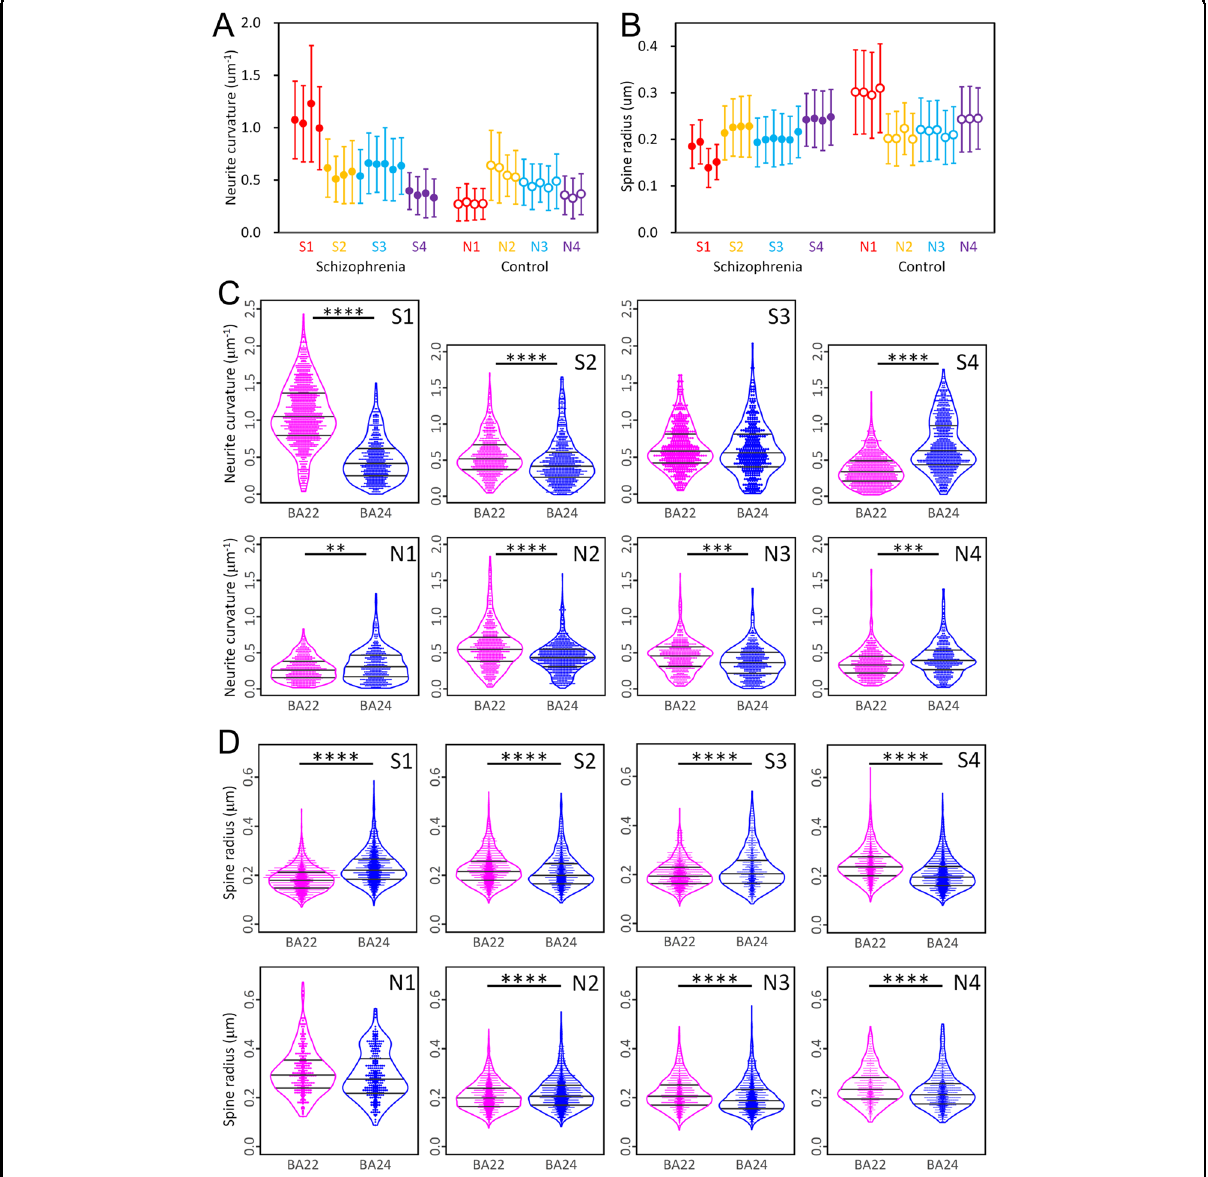
Fig. 2 Differences in neuron structure between brain areas and between cases. A , B Neurite curvature ( A ) and spine thickness radius ( B ) of temporal (BA22) cortex calculated from each dataset vary depending on the cases ( p = 2.9 × 10 − 8 and F = 91.7, for neurite curvature, p = 4.5 × 10 − 8 and F = 74.9, for spine radius, Welch ’ s ANOVA with case as the main factor). Schizophrenia cases S1 – S4 and age/gender-matched control cases N1 – N4 are color-coded. Neurite curvature was calculated by averaging the curvature along the neurite. Spine radius was calculated by averaging the thickness radius along the dendritic spine. Circles indicate mean values of each dataset, and error bars indicate standard deviation. C , D Frequency distribution of neurite curvature ( C ) and spine radius ( D ) of temporal (BA22) and prefrontal (BA24) cortexes of each case. Schizophrenia cases S1 – S4 and controls N1 – N4 are indicated with labels. The equality of distributions between BA22 and BA24 was examined using Kolmogorov – Smirnov test, and their p values were corrected with the Holm – Bonferroni method. **** p < 10 − 8 ; *** p < 10 − 4 ; ** p < 10 − 2 . Quartiles are indicated with bars. Dot size is adjusted for visibility. E Mean spine length is signi fi cantly shorter in BA22 than in BA24 (* p = 0.023, F = 6.7, two-way ANOVA with group (schizophrenia/control) and brain area (BA22/BA24) as main factors). Schizophrenia cases S1 – S4 and controls N1 – N4 are color-coded. F Mean neurite curvature is signi fi cantly higher in the schizophrenia cases than in the controls (* p = 0.031, F = 5.9, two-way ANOVA with group (schizophrenia/control) and brain area (BA22/BA24) as main factors). G Neurites of BA22 of the schizophrenia S1 case are tortuous and thin, H while those of the age/gender-matched control N1 case are smooth and thick. Structures of S1A and N1A are drawn to the same scale using MCTrace 22 . The pial surface is toward the top. Structural constituents are color-coded. Nodes composing each constituent are indicated with octagons. The color coding and structural orientation are the same as in Fig. 1B and Supplementary Fig. 5B. Scale bar: 10 μ m. I , J Cumulative distribution of neurite curvature of schizophrenia cases ( I ) and controls ( J ). Solid lines represent BA22 distributions, and dashed lines represent BA24 distributions. Cases are